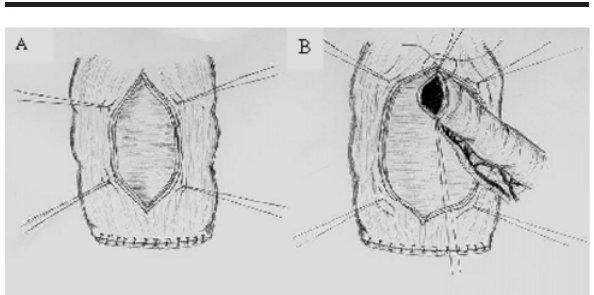
FIGURA 1 : A ) Cólon ascendente fechado terminalmente e camada seromuscular dissecada em 7 cm e descolada em 80% de sua circunferência. B ) Anastomose entre a camada mucosa do cólon e o coto caudal do íleo.